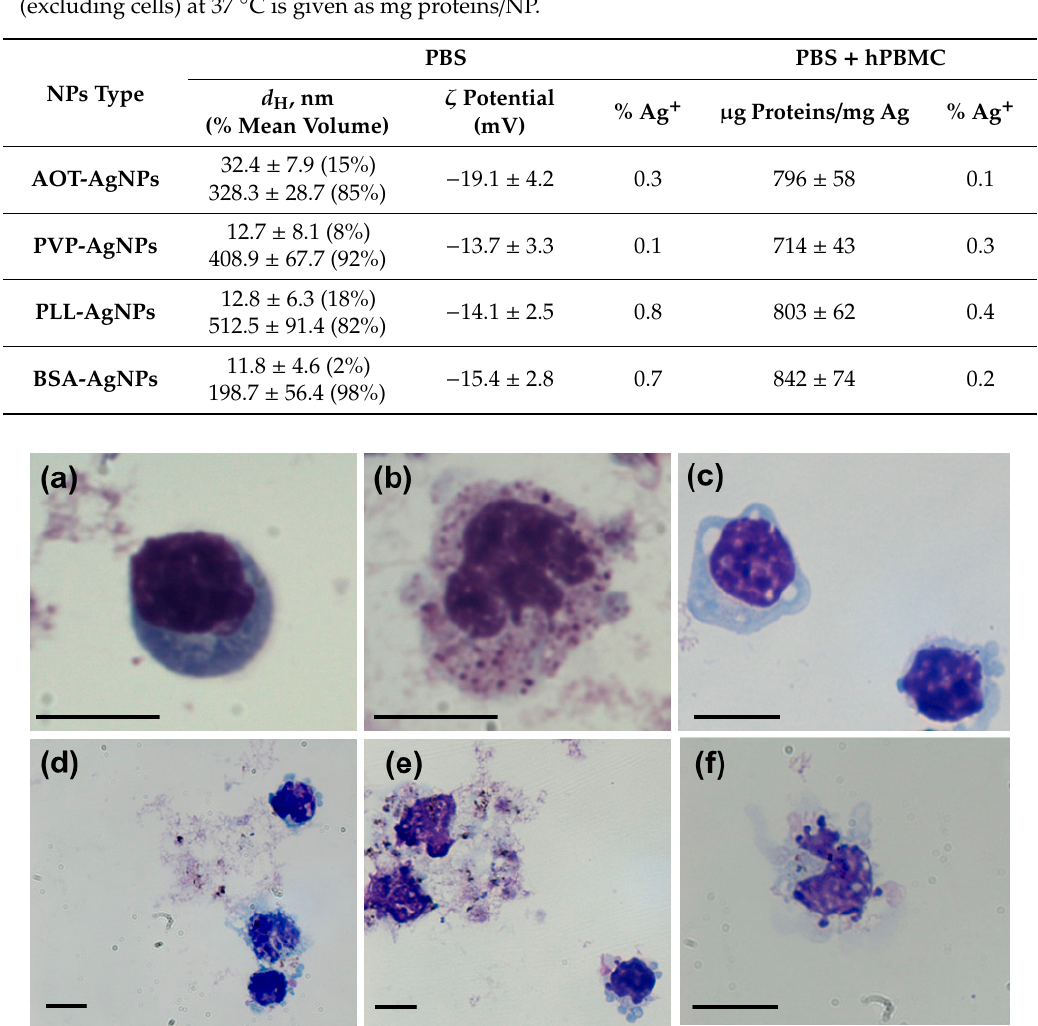
Table 2. Stability of AgNPs coated with AOT, PVP, PLL and BSA in PBS and PBS with addition of hPBMC. Hydrodynamic diameter ( d H , nm) values obtained from size distributions by volume and ζ potential values (mV) were measured 1 h after dispersion of AgNPs in PBS, while % of free Ag + ions was measured by GFAAS in filtrates obtained by centrifugal ultrafiltration of AgNPs dispersed in PBS and PBS + hPBMC media for 1 h at concentrations of 10 mg Ag / L and at 25 ◦ C. Quantitative analysis of protein corona formed on the surface AgNPs after 1 h incubation in PBS + hPBMC media (excluding cells) at 37 ◦ C is given as mg proteins / NP.